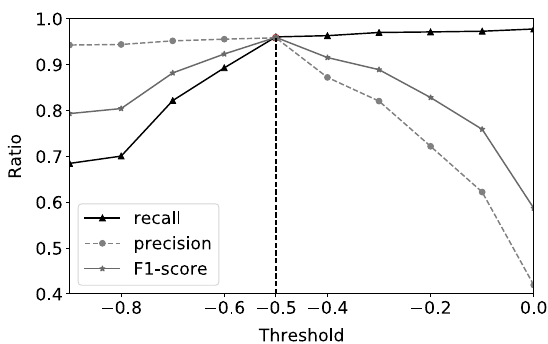
Fig. 7 The performance of VP extraction under different